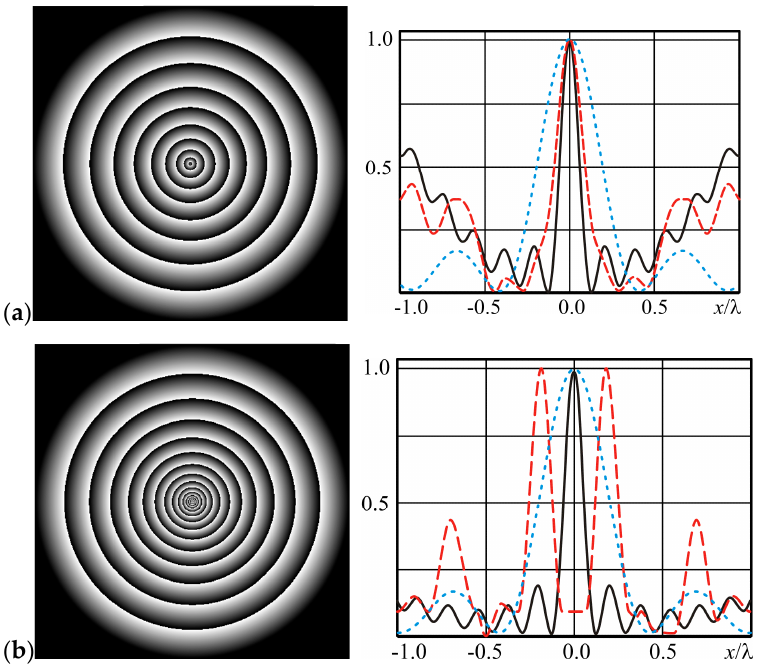
Figure 11. Generation of a compact light spot in the near-field zone by the fractional axicon ( ) exp r i k r γ τ = − α with ( a ) γ = 0.5, α 0 = 125 and ( b ) γ = 0.25, α 0 = 7937607: graphs show nor- malized intensity sections at distance of z = 0.01 λ (solid line), z = 0.1 λ (dashed line), and z = 2 λ (dotted line).